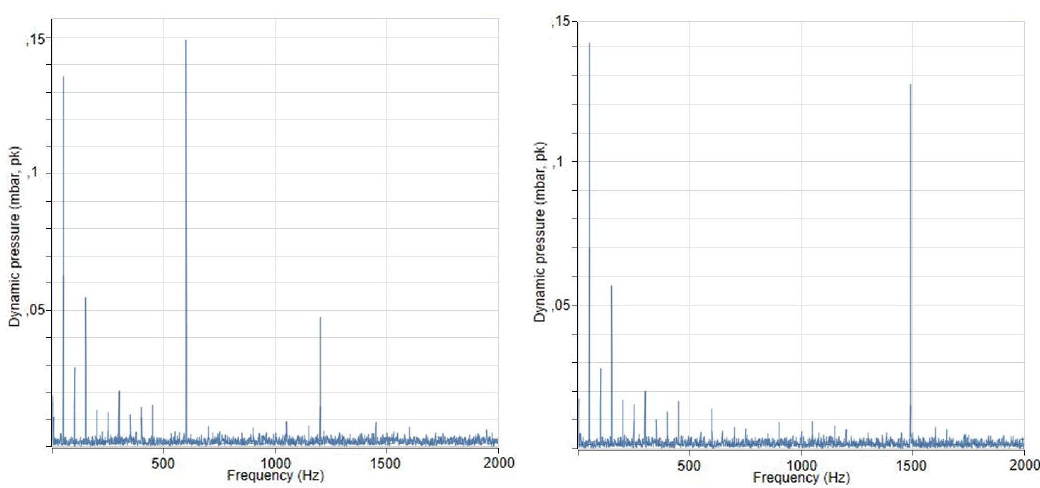
Figure 13. Acoustic forcing using the sirens at 608 and 1488 Hz and measured acoustic pressure